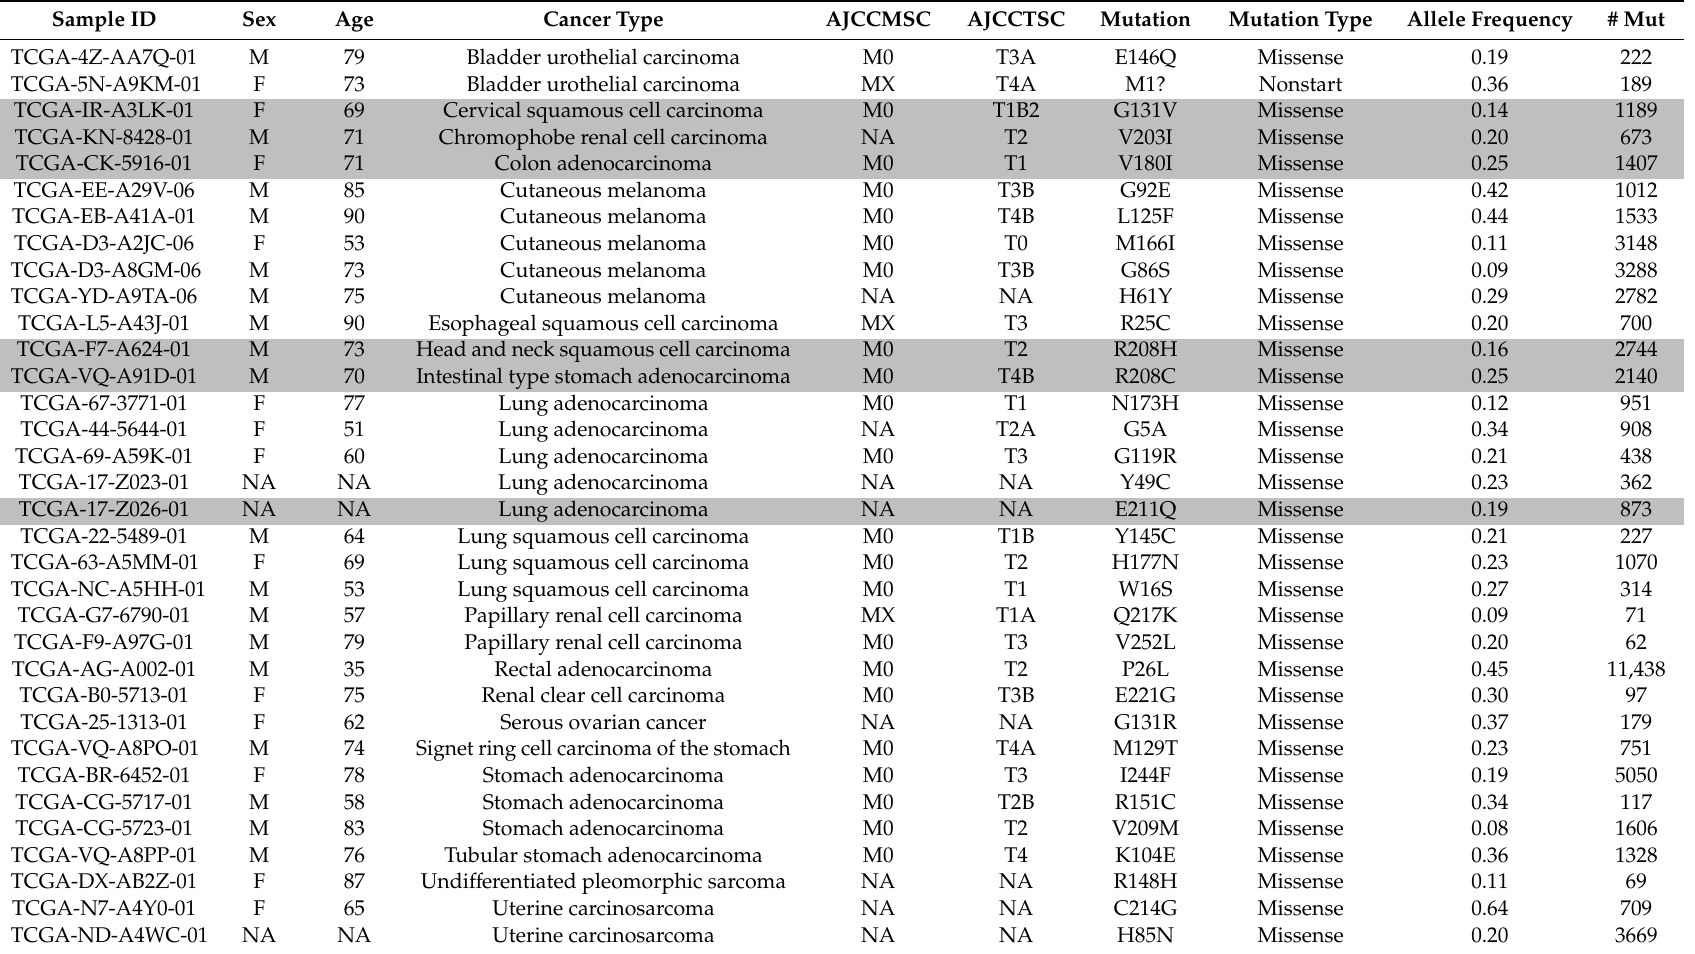
Table 2. Detailed information on the 48 somatic mutations in cancer